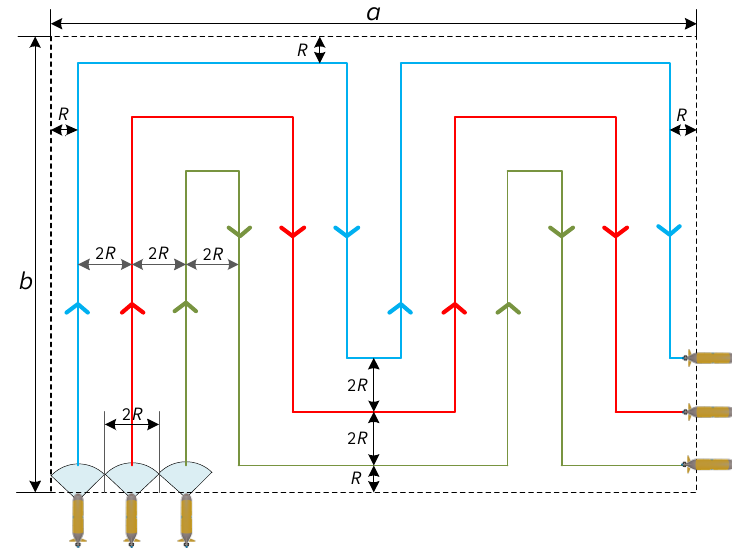
Figure 2. Boustrophedon paths.